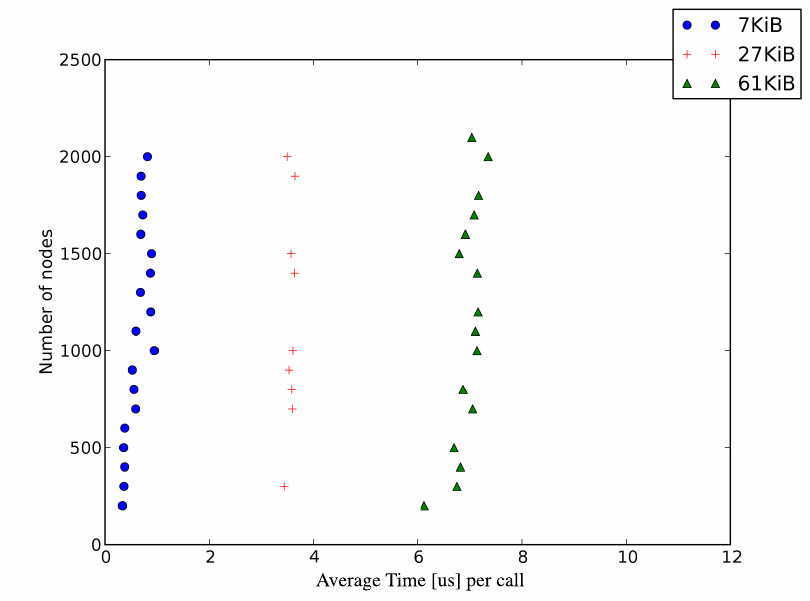
Figure 12. Function call time in relation to simulation